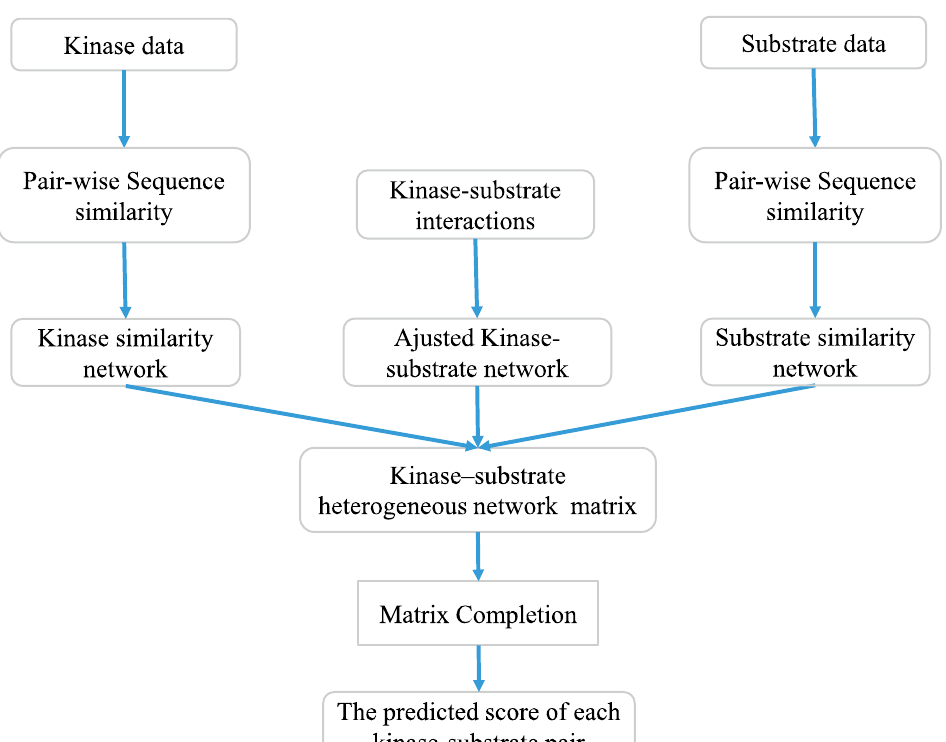
Figure 5. The flow chart of potential kinase–substrate interactions identification by using matrix completion.